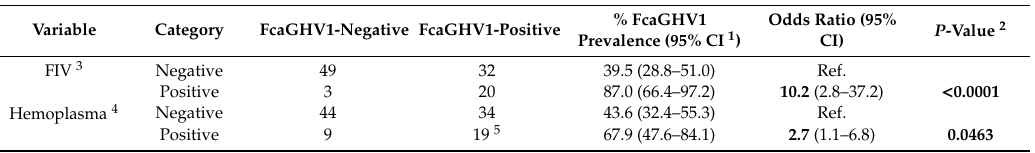
Table 5. Feline immunodeficiency virus (FIV) infection and feline hemoplasma infection in selected samples from the 881 cats presented to Swiss